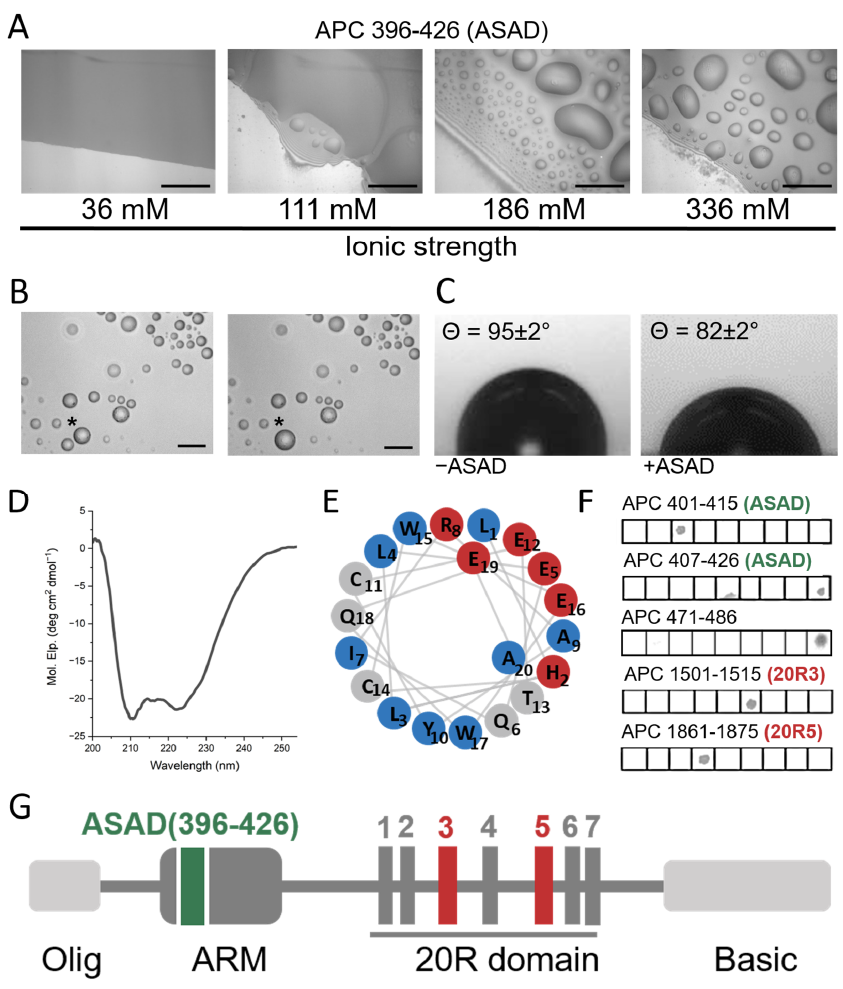
Figure 2. The ASAD binds itself and forms droplets via hydrophobic interactions. ( A ) The ASAD forms droplets in an ionic-strength-dependent manner. All images were taken after 5 min of incu- bation and show fusion of the droplets (Figure 2B). Scale bar = 20 µM. ( B ) A fusion event between two droplets. Fusion of droplets was monitored for the p20R5CK1 peptide undergoing LLPS. Shown are droplets of p20R5CK1 before (left) and 6 s after (right) they fused to form a larger droplet. The droplets before and after fusion are labeled by (*). Scale bar = 20 µ m. ( C ) contact angle experiments of the ASAD on a glass slip covered by parafilm show that addition of the ASAD creates a more hy- drophobic environment in the solution. ( D ) CD spectra show that the ASAD is α -helical. ( E ) A wheel projection of the ASAD shows that it forms a charged patch on one (red circles) and hydrophobic patch (blue circles) on the other side of the α -helix. ( F ) Peptide array screening of the ASAD binding to APC peptides shows that the ASAD binds itself, to helix 2 in the ARM domain it is part of and to two 20Rs domains (20R3 and 20R5). The spot on the 5th square on APC407-426 (ASAD) line is an artifact, caused by bleeding from the signal in the square below (which is not shown). ( G ) Domain structure of the APC protein. With the position of the ASAD and 20R3/5 indicated in green and red